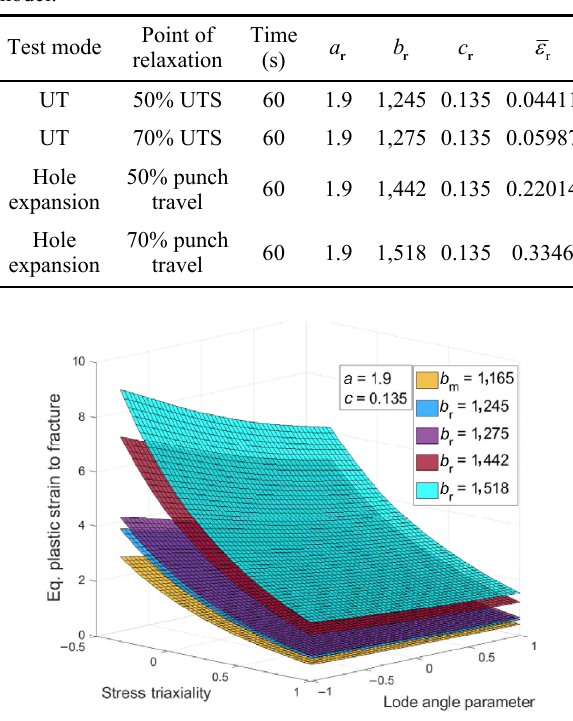
Fig. 7 Representation of fracture surfaces of HC model (in the above plot, m